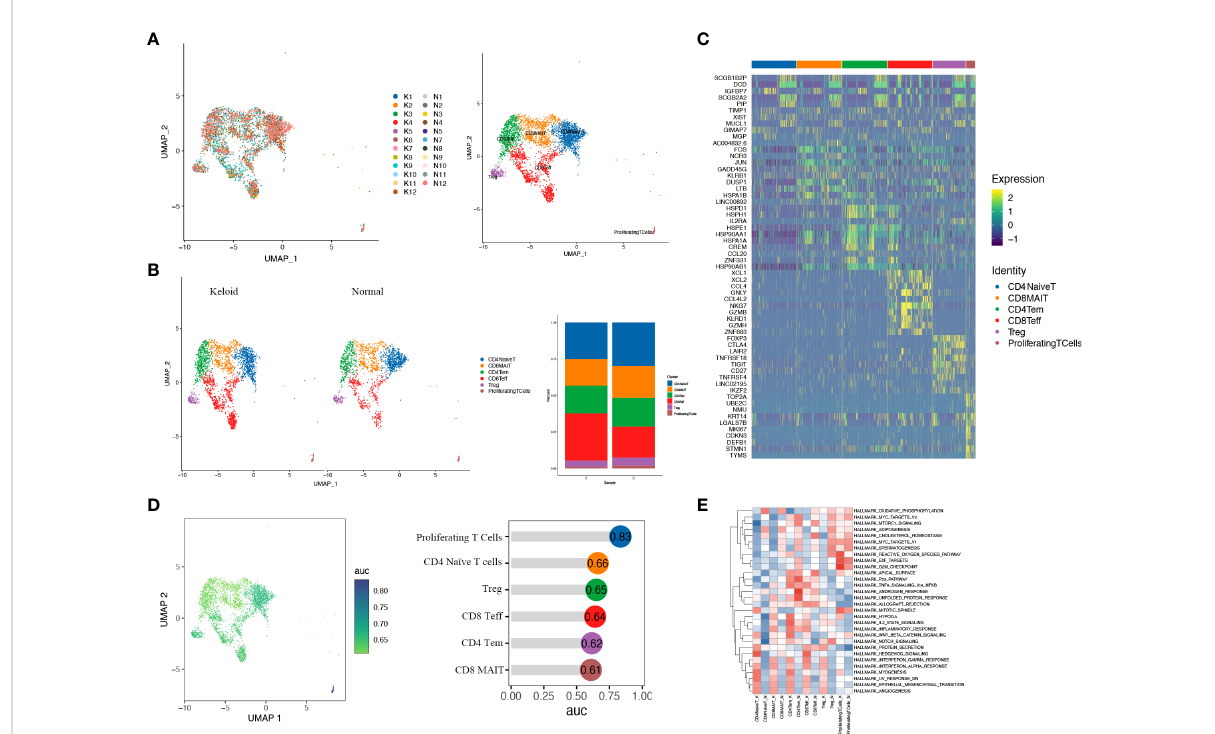
FIGURE 4 T cells of keloid and normal skin tissues were subdivided into different cell subsets. (A) Six different subsets of T cells are identi fi ed in keloid and normal tissues: CD4+ naïve T cells (CD4NaiveT), CD4+ effector memory T cells (CD4Tem), CD8+ effector T cells (CD8Teff), CD8+ mucosa- associated invariant T cells (CD8MAIT), CD4+ regulatory T cells (Treg), and proliferating T cells. (B) The ratio of six T-cell subsets in keloid and adjacent normal tissues is shown. (C) Heatmap illustrating representative differentially expressed genes among the six T-cell subsets. (D) Augur analysis indicates that proliferative T cells are the cell type with the greatest variation among subsets. (E) Enrichment analysis of differentially expressed genes in the six T-cell